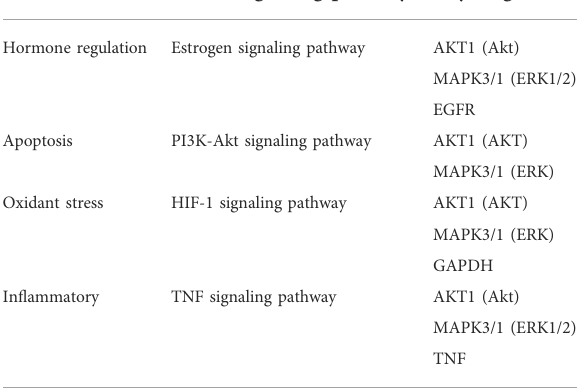
TABLE 6 The most signi fi cant KEGG signaling pathways and key targets.